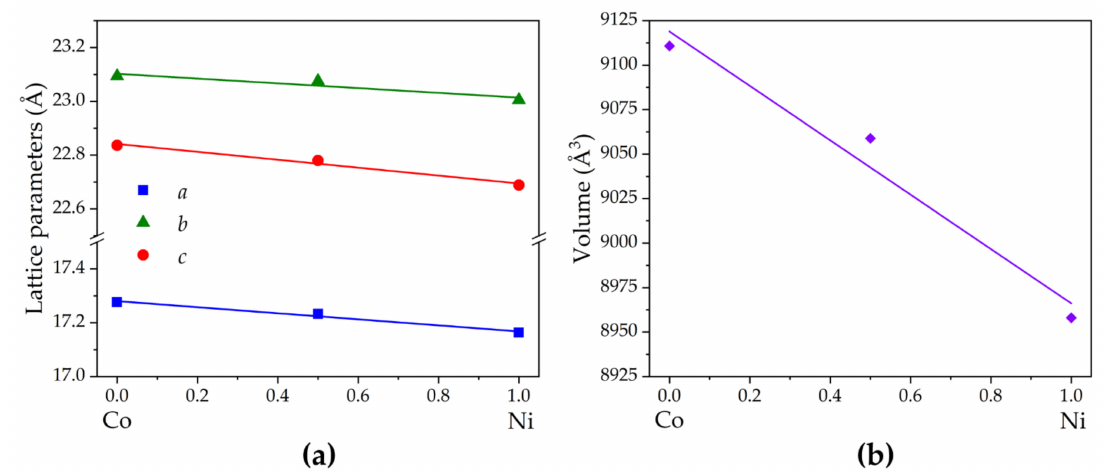
Figure 3. ( a ) Lattice parameters and ( b ) unit cell volume for [TPrA][Co x Ni (1 − x) (dca) 3 ], where x = 1.0, 0.5 and 0.0.